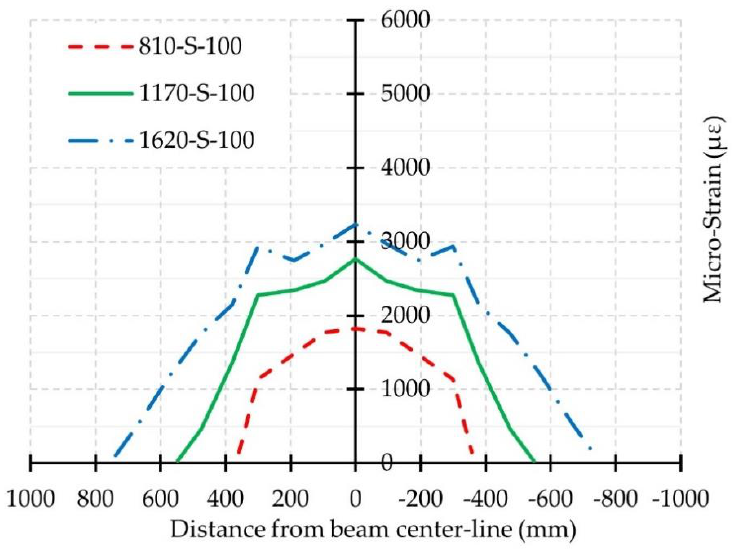
Figure 26. Strain distribution along the HFRP strips of 810-S-100, 1170-S-100 and 1620-S-100 at 380 kN.